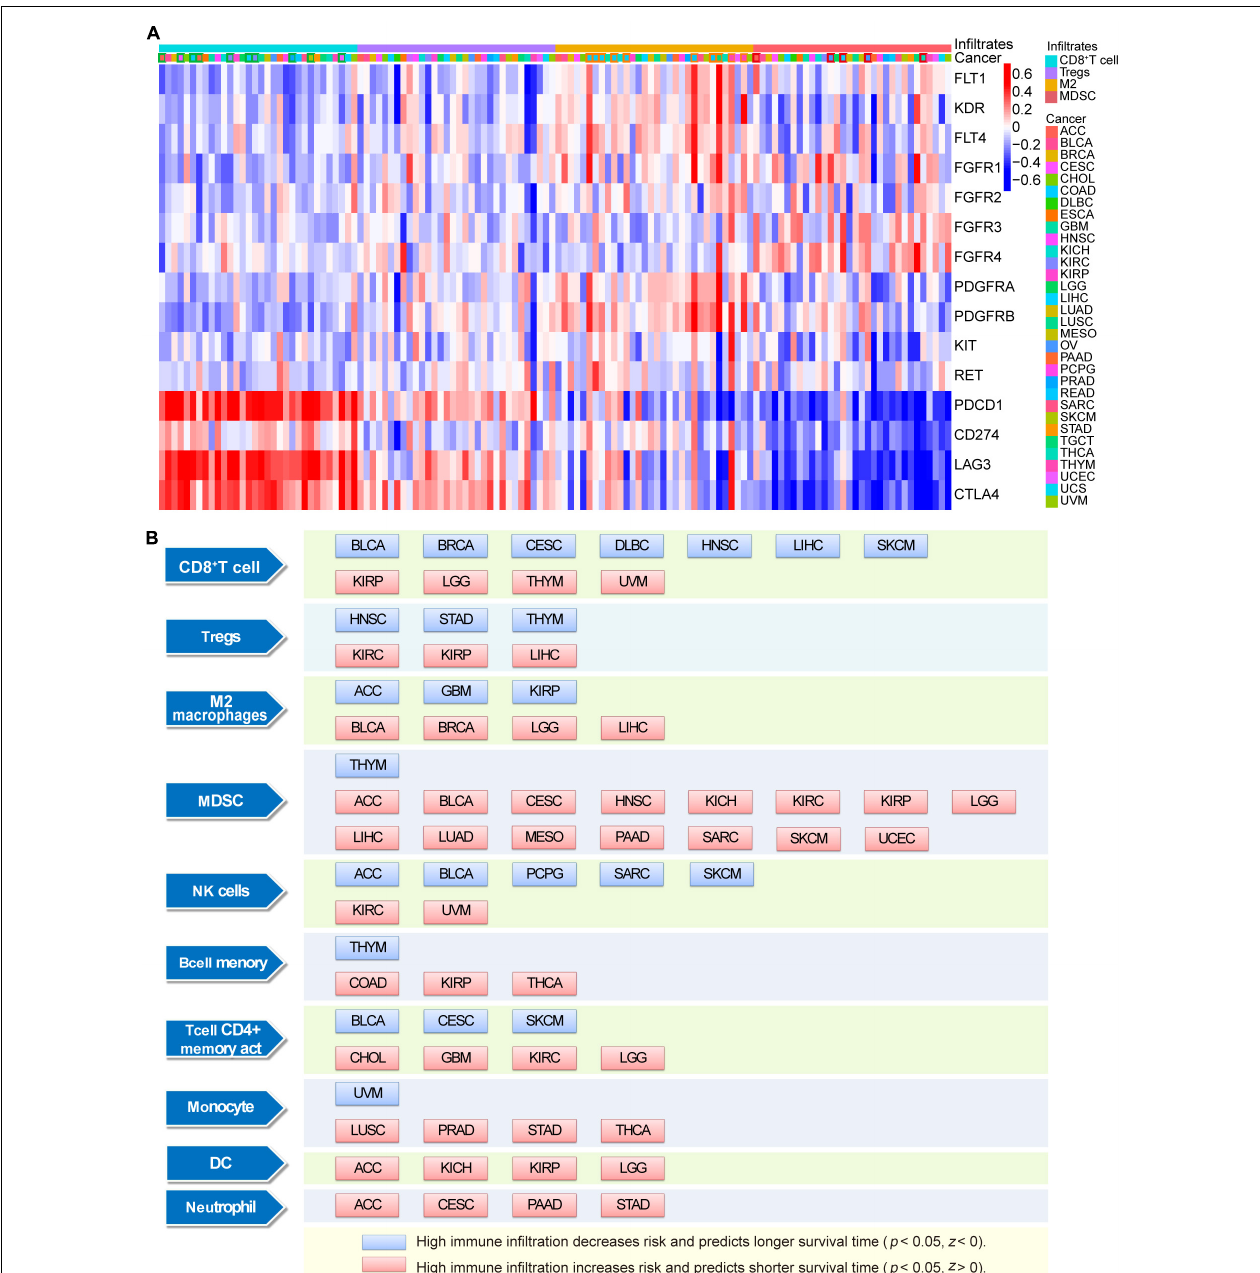
FIGURE 5 | Correlation and survival analysis of immune infiltrating cells with ICB and lenvatinib target genes. (A) The correlation between ICB and lenvatinib target genes and tumor infiltration immune cells. The cancer types indicated with a green box if ≥ 8 positive correlations and more than 4 of them have an r ≤ –0.15, and the cancer types indicated with an orange or red box if ≥ 8 negative correlations and more than 4 of them have an r ≥ 0.15. (B) The relationship between immune infiltrates and survival outcomes in malignancy. The blue square represents high immune infiltration decreases risk and predicts longer survival time in certain tumors ( P < 0.05, Z < 0), and the red square represents high immune infiltration increases risk and predicts shorter survival time in certain tumors ( P < 0.05, Z > 0). Z represents normalized coefficient. DC, dendritic cells; M2, M2 macrophages; MDSC, myeloid-derived suppressor cells.